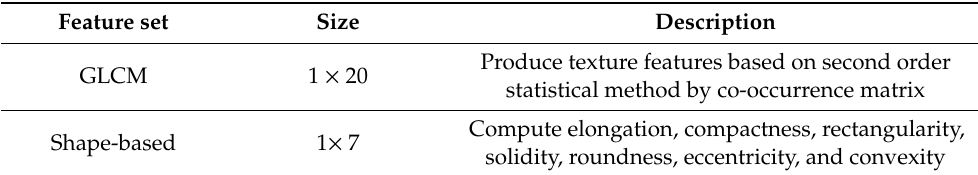
Figure 6. ( a ) Area of breast lesion; ( b ) minor axis and major axis. Table 4. Employed features description. Table 4. Employed features description.